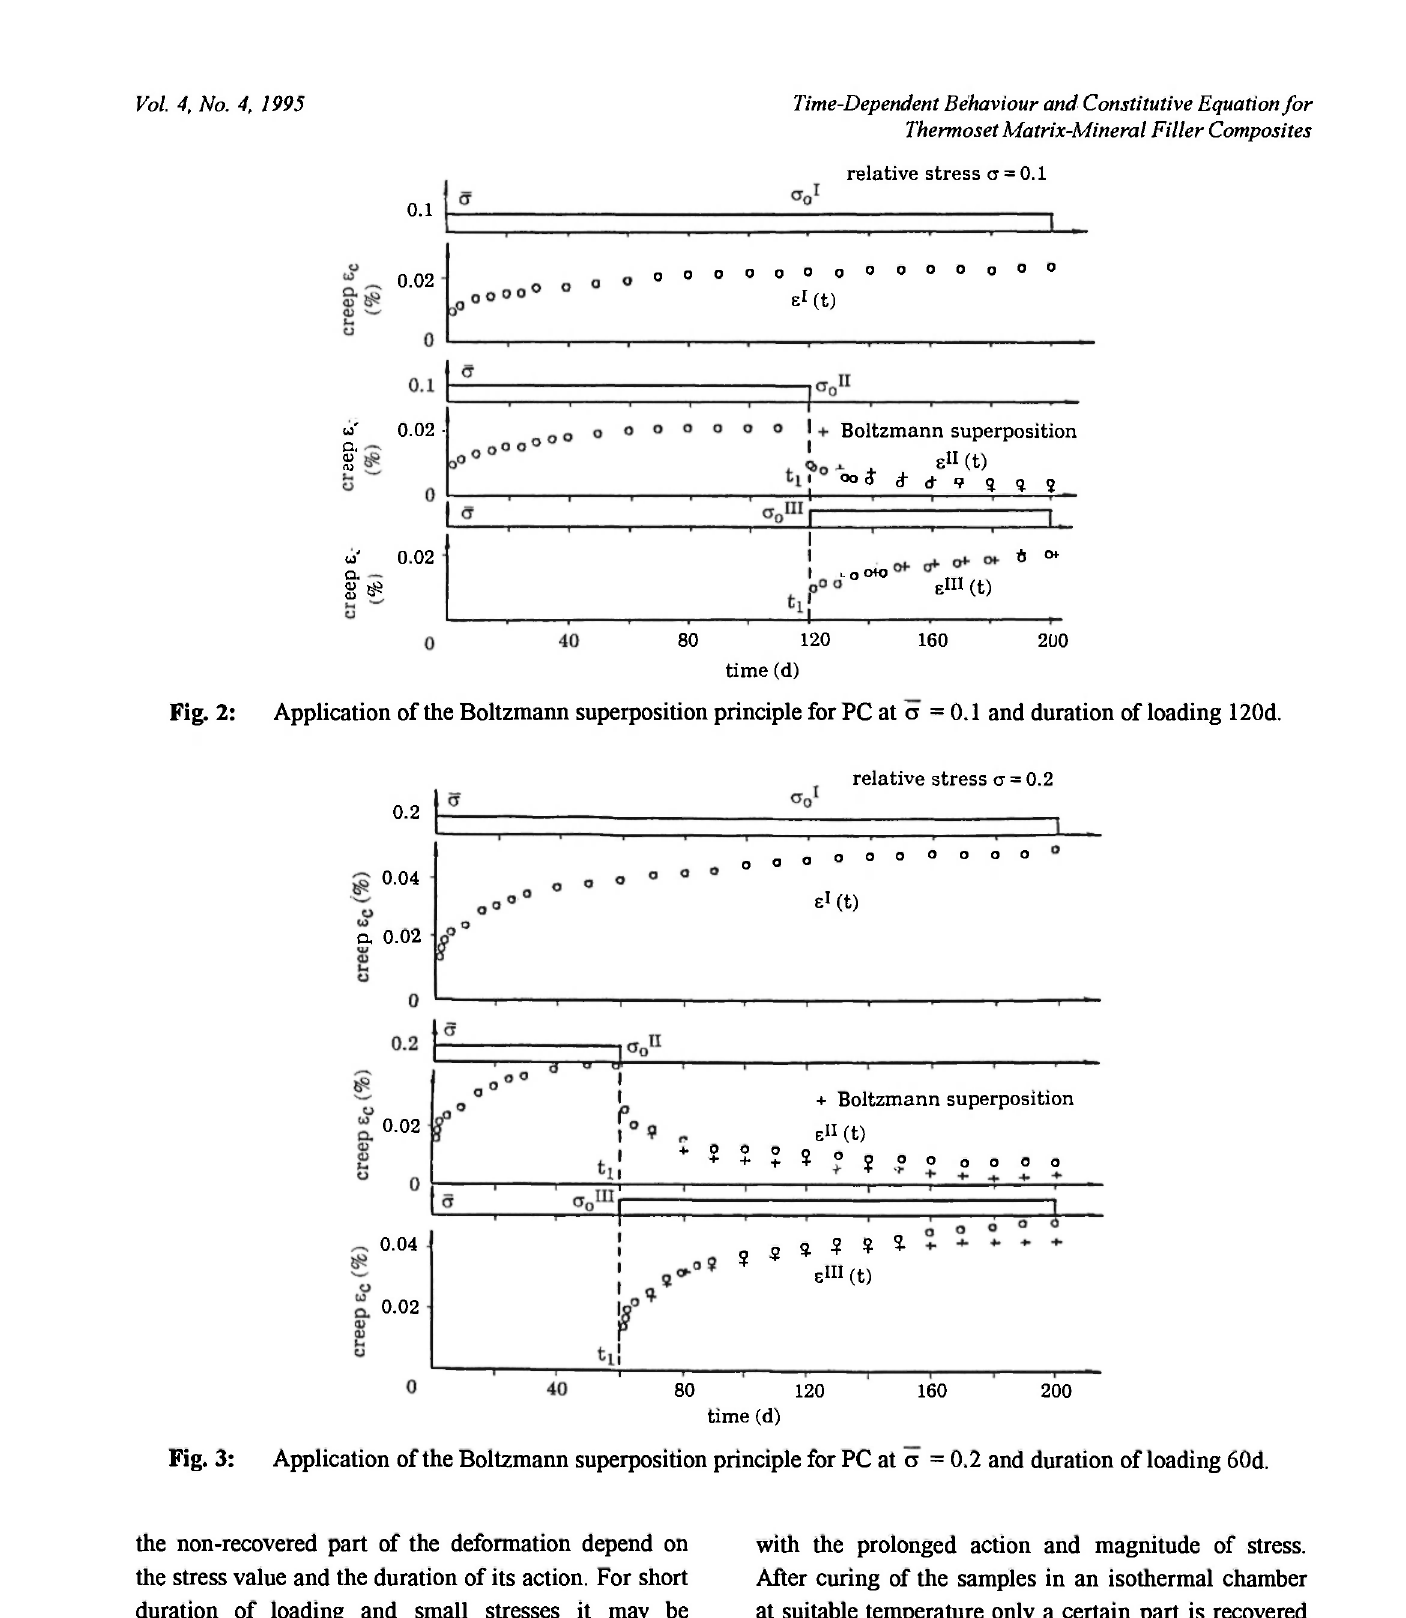
with the prolonged action and magnitude of stress. After curing of the samples in an isothermal chamber at suitable temperature only a certain part is recovered of the deformation which is non-recovered under normal